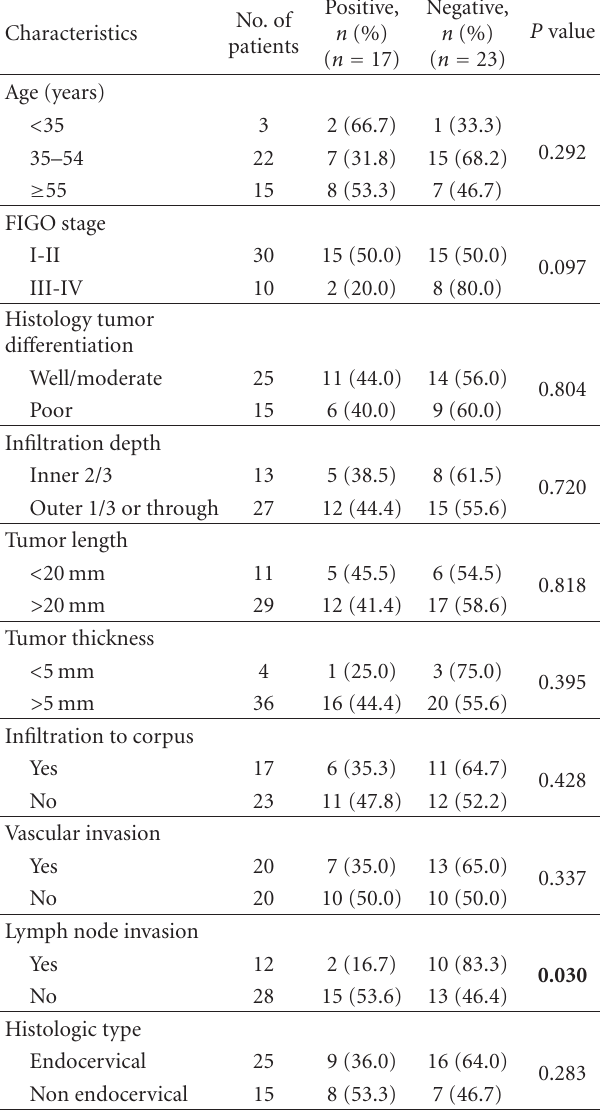
Table 6: Associations between p27Kip1 expression and clinico- pathologic parameter for endocervical adenocarcinoma.